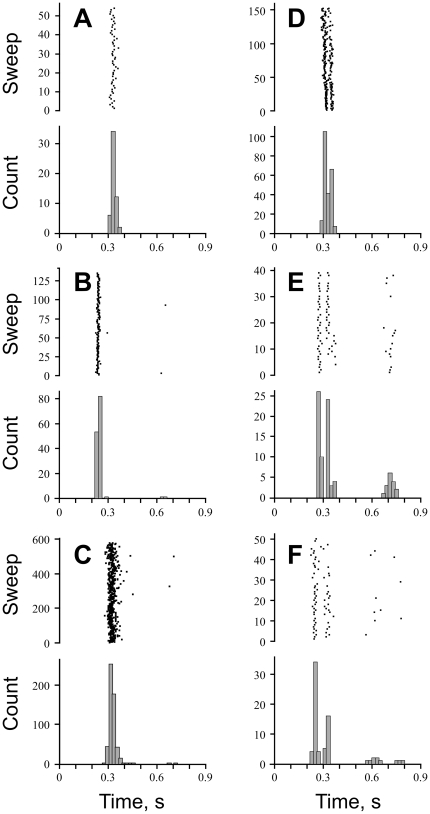
Pulse-wave driven muscle spindles.Each panel shows post stimulus time histogram at the bottom and raster sweeps of single cardiac cycles on top. A–C, Afferents typically responded with one single spike phase-locked to the cardiac cycle. D–F, Afferents responding with two spikes at the time corresponding to the pulse wave upbeat. A third spike corresponding to the time of dicrotic notch is generated by afferents depicted in E and F (see also B&D). Each bar indicates total count of spikes falling within corresponding 0.02 s time bin. Each dot in raster plot indicates one spike.